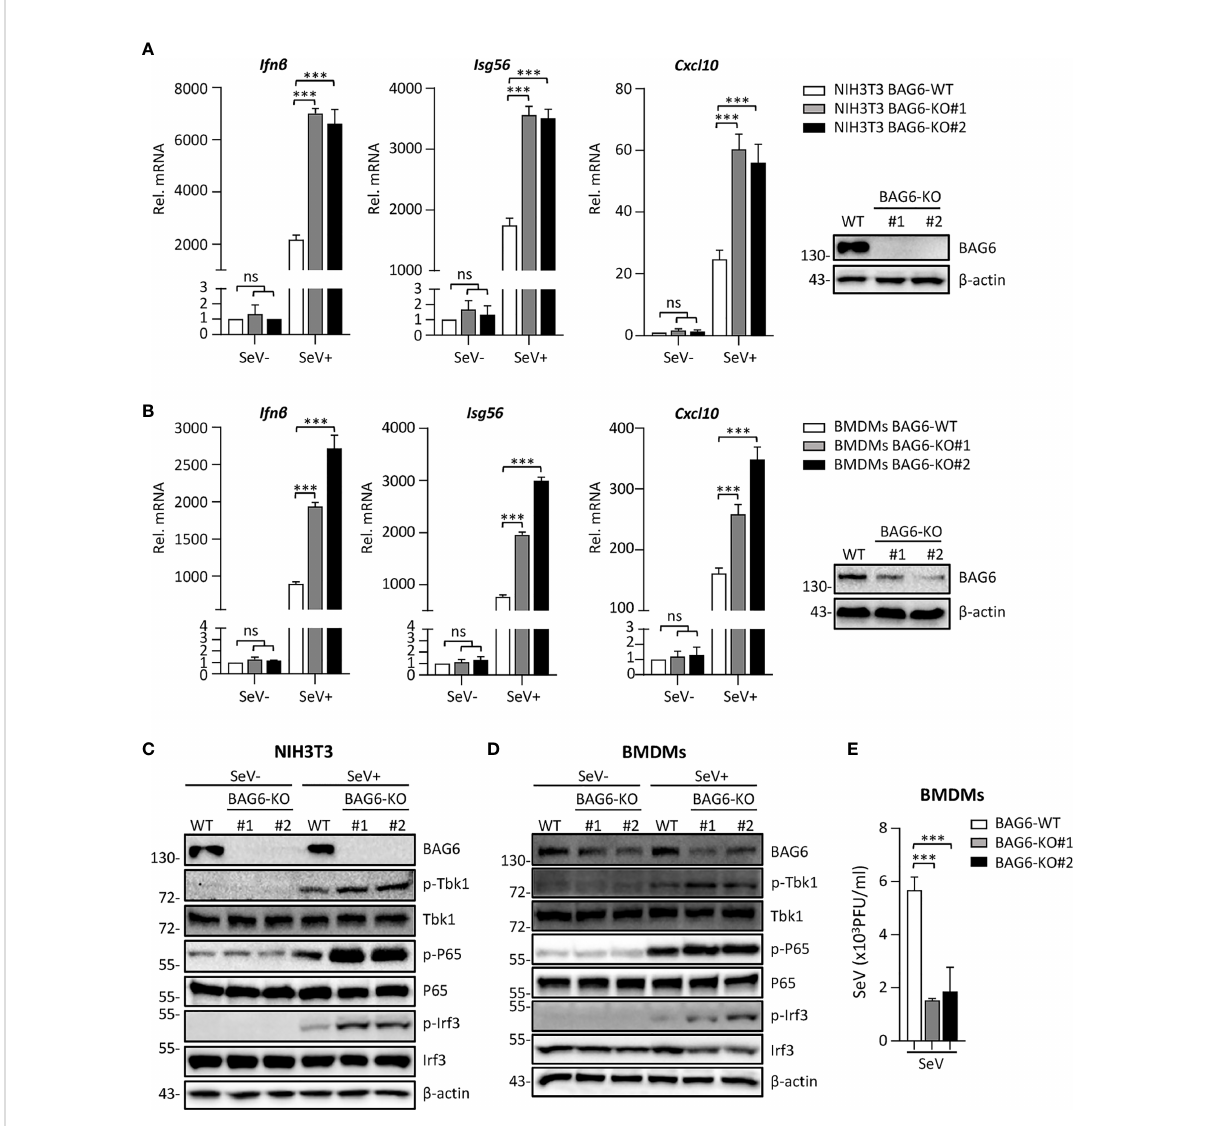
FIGURE 4 BAG6-de fi ciency signi fi cantly increases the RLR signaling in primary immune cells. (A) BAG6-de fi ciency enhances the transcription of downstream antiviral genes in NIH3T3 cells. BAG6-de fi cient NIH3T3 cells were left uninfected or infected with SeV (MOI = 1) for 8 h before qPCR analysis. (B) BAG6-de fi ciency enhances the transcription of downstream antiviral genes in mouse BMDMs. Mouse wild-type BMDMs (4×10 6 ) were infected with lentivirus containing BAG6-CRISPR CAS9 sgRNA, the supernatants were replaced with fresh medium after 48 h, and the cells were infected with SeV (MOI = 1) for 8 h before qPCR analysis. (C, D) BAG6-de fi ciency enhances RNA virus-induced phosphorylation of TBK1, P65, and IRF3. BAG6-de fi cient NIH3T3 and BMDMs were untreated or treated with SeV for 8 h before immunoblotting. (E) Effects of BAG6-de fi ciency on virus replication. BAG6-de fi cient and wild-type BMDMs cells were infected with SeV (MOI = 0.1) for twenty hours. The supernatants were collected for plaque assays. (*** p < 0.001; ns, no signi fi cant